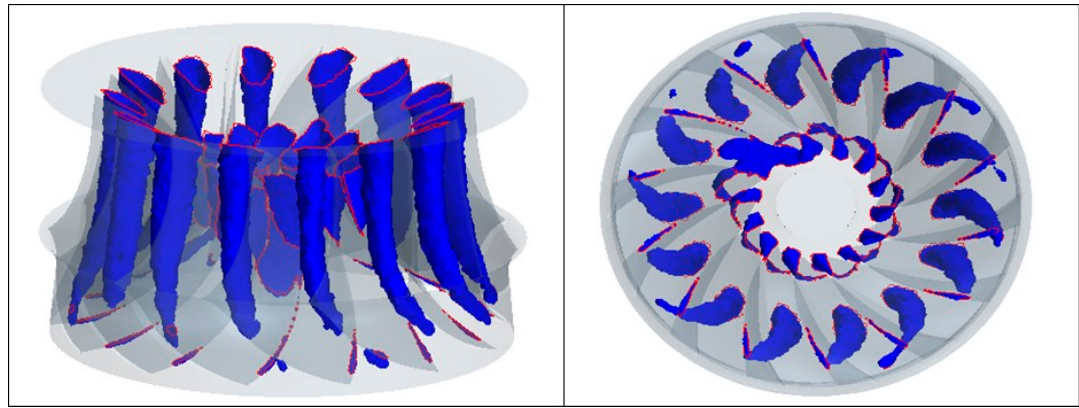
Figure 2. Visualization of cavitation vortices in the turbine runner by means of isocontours of void ratio 0.1 at 16 MW.